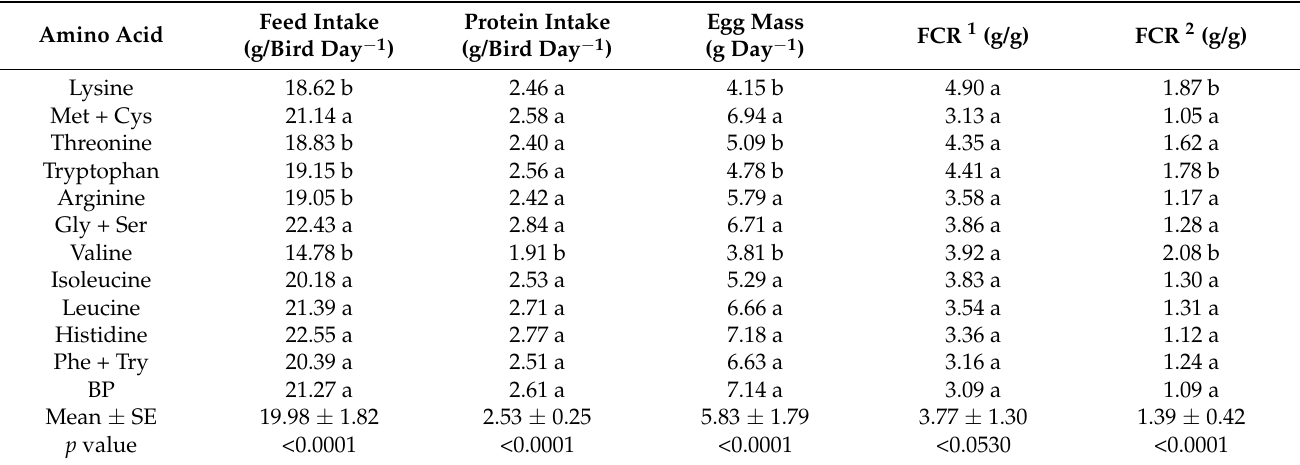
Table 4. Average responses to dietary limited in amino